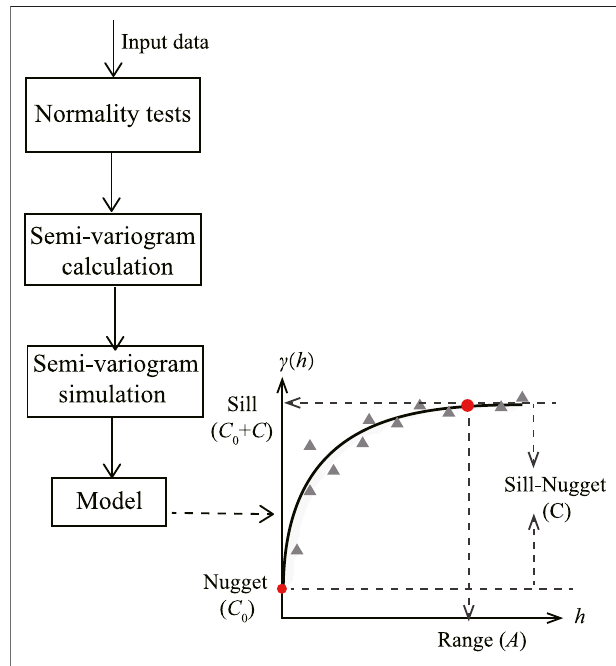
FIGURE 1 | Flowchart of quantitative system robustness index [30]. The analysis of semivariogram is mainly divided into three phases: normal test of research data, calculation of the semi-variance of variable, and simulation semivariogram toobtainthe best fi tted model. Structural ratio C /( C 0 + C ) can re fl ect the robustness of the